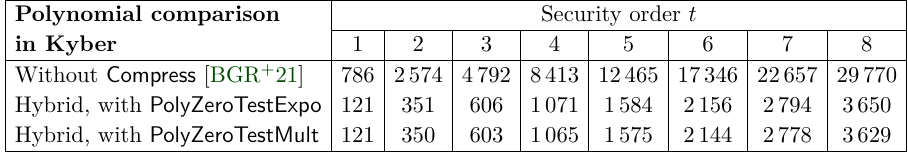
Table 9: Operation count for the three proposed methods to perform ciphertext comparison (with Compress and without Compress using PolyZeroTestExpo or PolyZeroTestMult ), in thousands of operations.